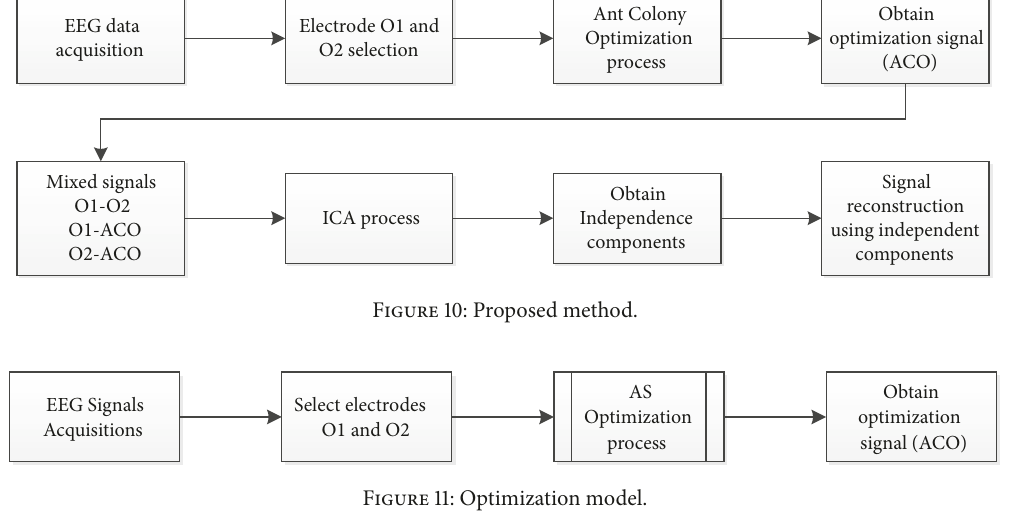
Figure 11: Optimization